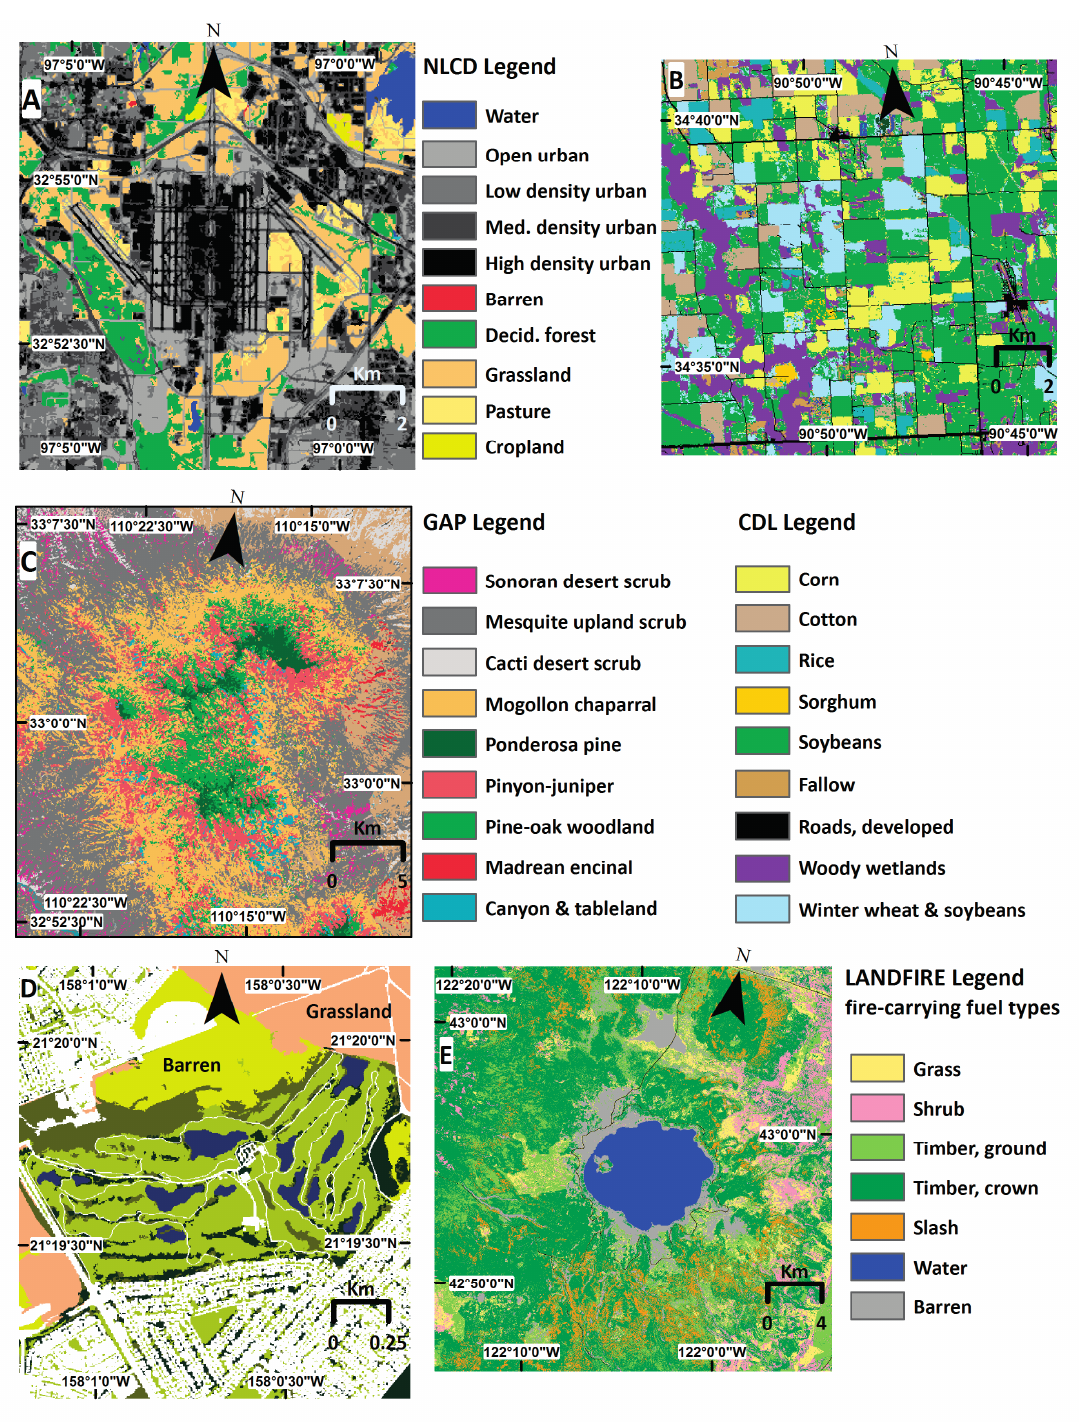
Figure 1. National Land Cover Database (NLCD) in the vicinity of the Dallas-Ft. Worth airport ( A ); Cropland Data Layer (CDL) in eastern Arkansas ( B ); Gap Analysis Program (GAP) in southeast Arizona ( C ); high resolution Coastal Change Analysis Program (C-CAP) in the vicinity of Ewa Beach, Hawaii ( D ); and Landscape Fire and Resource Management Planning Tools (LANDFIRE) data in the vicinity of Crater Lake, Oregon ( E ). Many of the GAP and LANDFIRE classes have been simplified for purposes of presentation (e.g., Sonoran desert scrub = Sonoran Paloverde-Mixed Cacti desert scrub). The LANDFIRE classes are a simplification of the 13 Anderson fire behavior fuels models